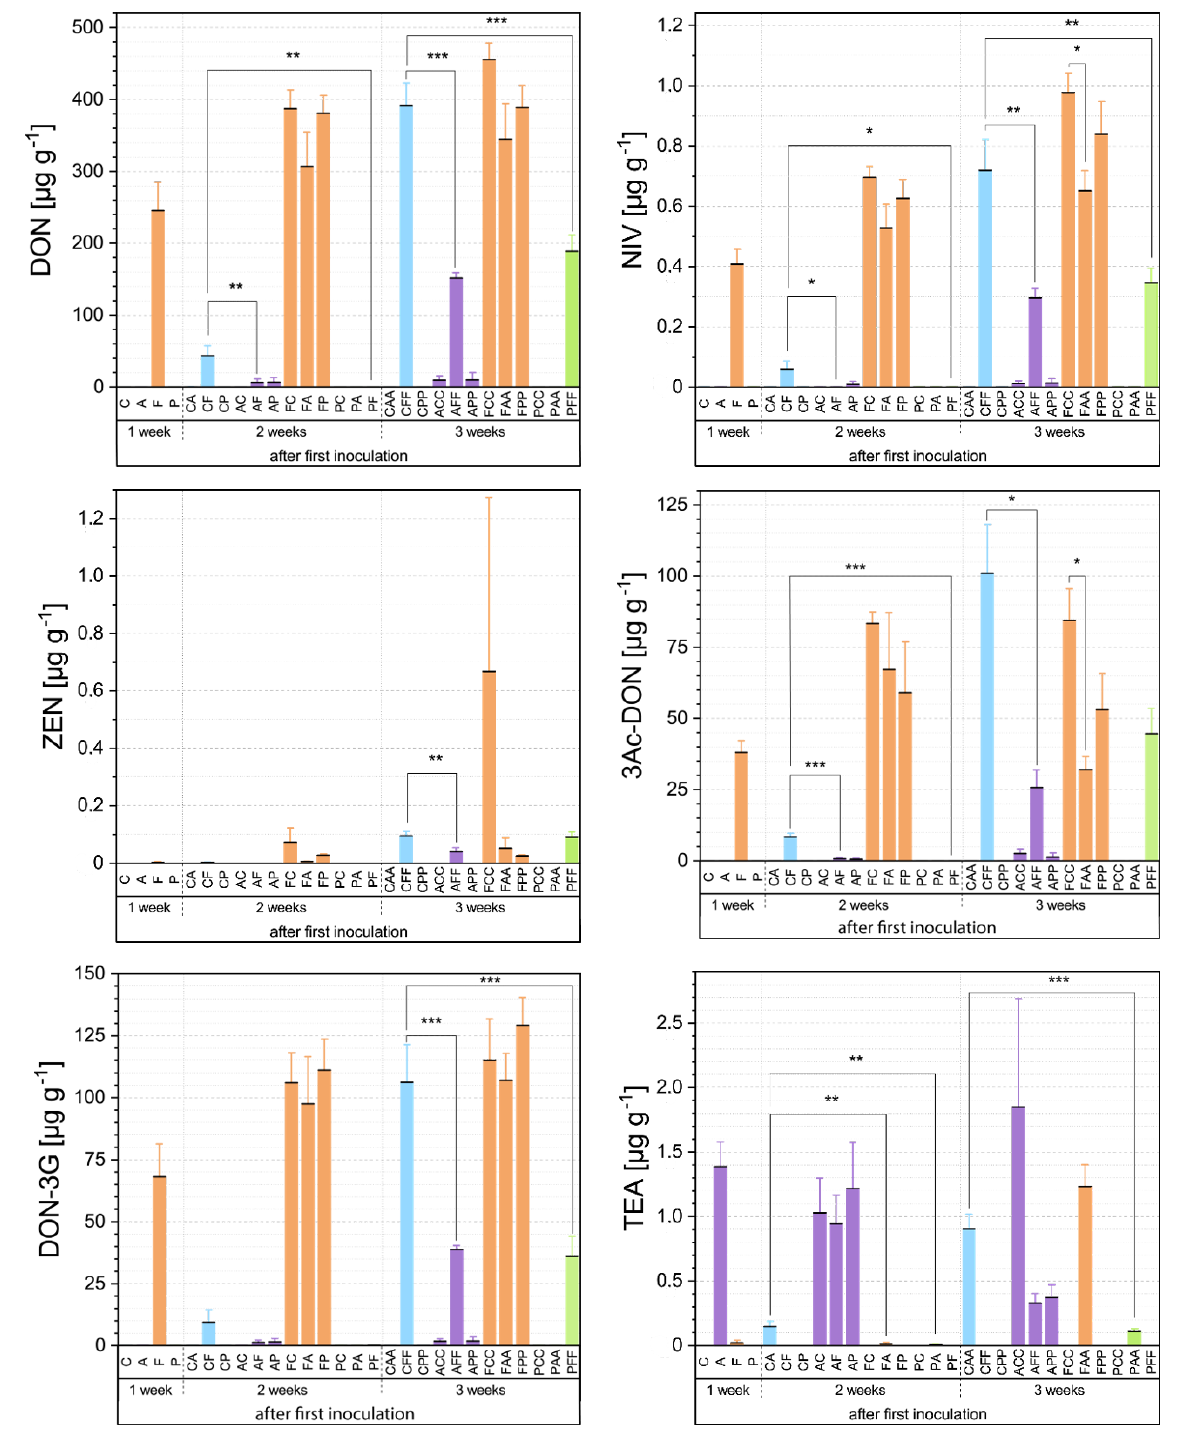
Figure 5. Bar plots of the mycotoxins of the inoculation experiment (DON = deoxynivalenol, NIV = nivalenol, ZEN = zearalenone, 3-Ac-DON = 3-acetyl deoxynivalenol, DON-3G = deoxynivalenol-3 glucoside, and TeA = tenuazonic acid). Chronical sequence of sampling is indicated by sample ID with C=control with 1/4 sterile Ringer’s solution; A= Alternaria tenuissima At 625, F = Fusarium graminearum Fg 23, P= Pseudomonas simiae Ps 9. The mean values are plotted with their standard errors of the mean. Asterisk brackets indicate significant differences (* p <0.1, ** p <0.05, *** p